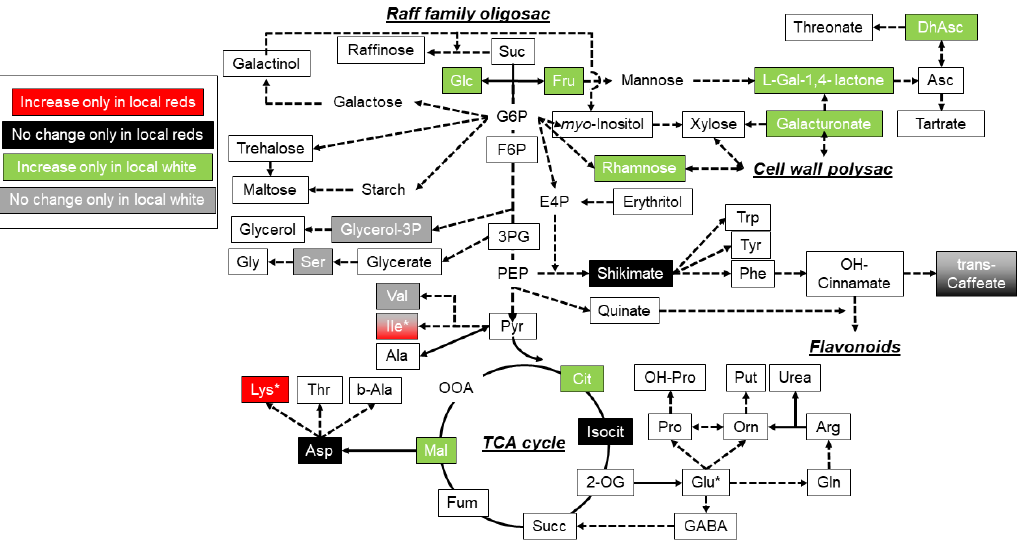
Figure 4. Metabolic model showing di ff erences in the water deficit stress (WDS) response of leaf primary metabolism between widespread and local cultivars. Metabolites highlighted are those showing significant ( p < 0.05) increase only in both local red (red) or in the local white (green) cultivars as compared to their corresponding widespread ones. Metabolites not significantly changing ( p > 0.05) only in local red (black) and white (grey) cultivars (i.e., only significantly changing in widespread cultivars) are also highlighted. Data used was taken from Figure 1. For the metabolite abbreviations see Figure 3. *Only significantly ( p < 0.05) increased in Callet although Escursac displayed a very similar trend.